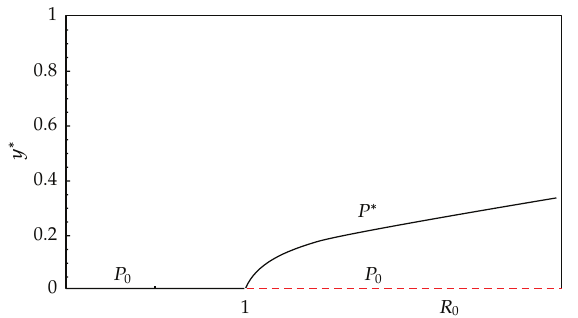
Figure 4: Bifurcation diagram in the plan (cid:6) R 0 ,y ∗ (cid:7) . The solid lines denote stability; the dashed lines denote